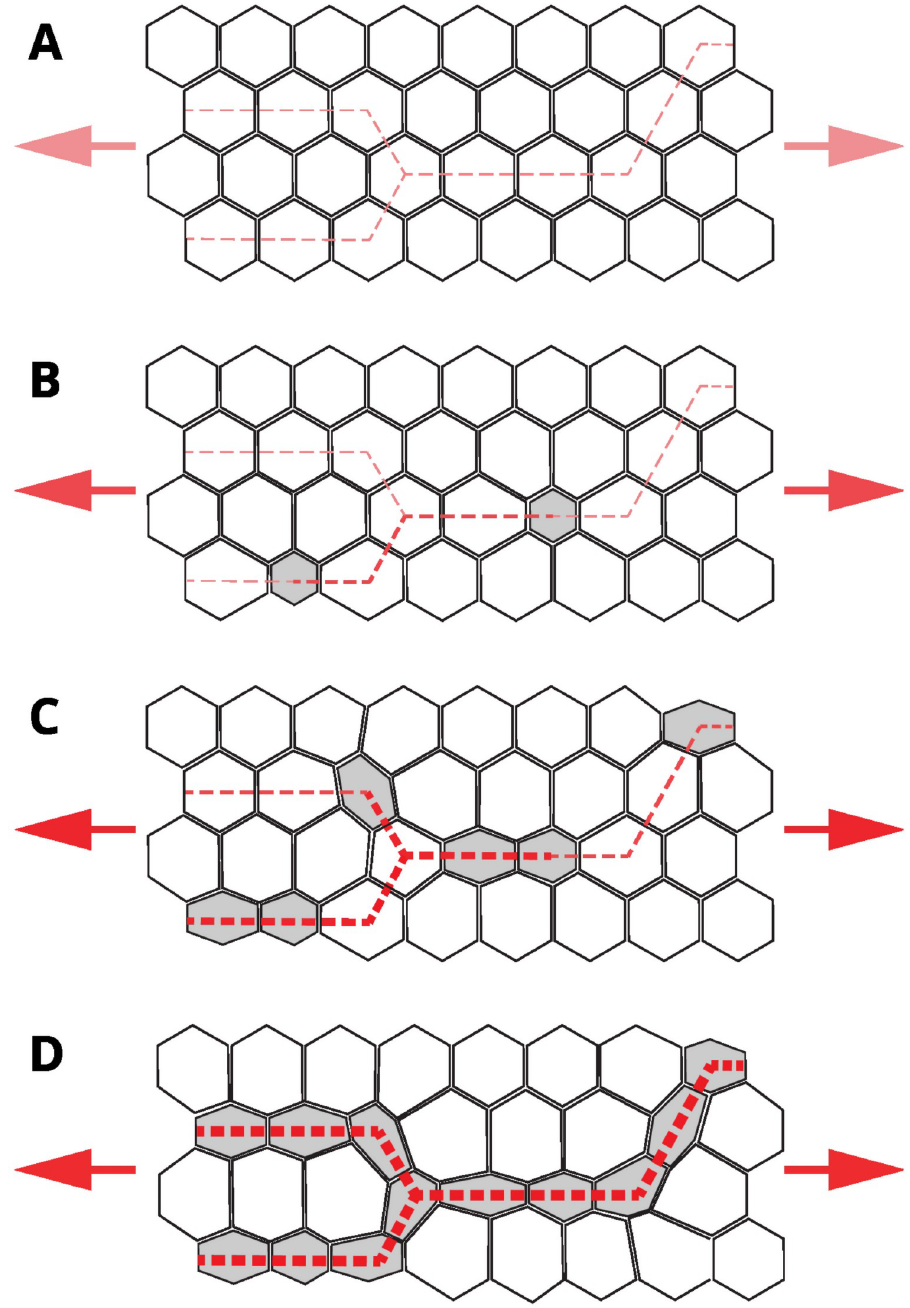
Fig 15. Schematic model for tensile stress-propagated apical constrictions in the early ventral furrow primordium. ( A ) The specified VF primordium is a mechanically active tissue under regional tensile stress from the adjacent anterior and posterior ends containing constricted cells (arrowheads, red). Example lines of tensile stress (dashed lines, red) in the tissue before apical constrictions begin. ( B ) Early ratcheted apical constrictions (gray) are distributed along the lines of tensile stress, but do not appear connected. As cell apices constrict, tensile stress increases along the stress lines (indicated by darker red coloration and greater thickness at dashed lines). ( C ) A later timepoint showing more apical constrictions (gray) forming along the lines of tensile stress. ( D ) The VF primordium before the fast phase of rapid apical constrictions initiated by the Fog and T48 signaling pathways. Apical constrictions are visible in